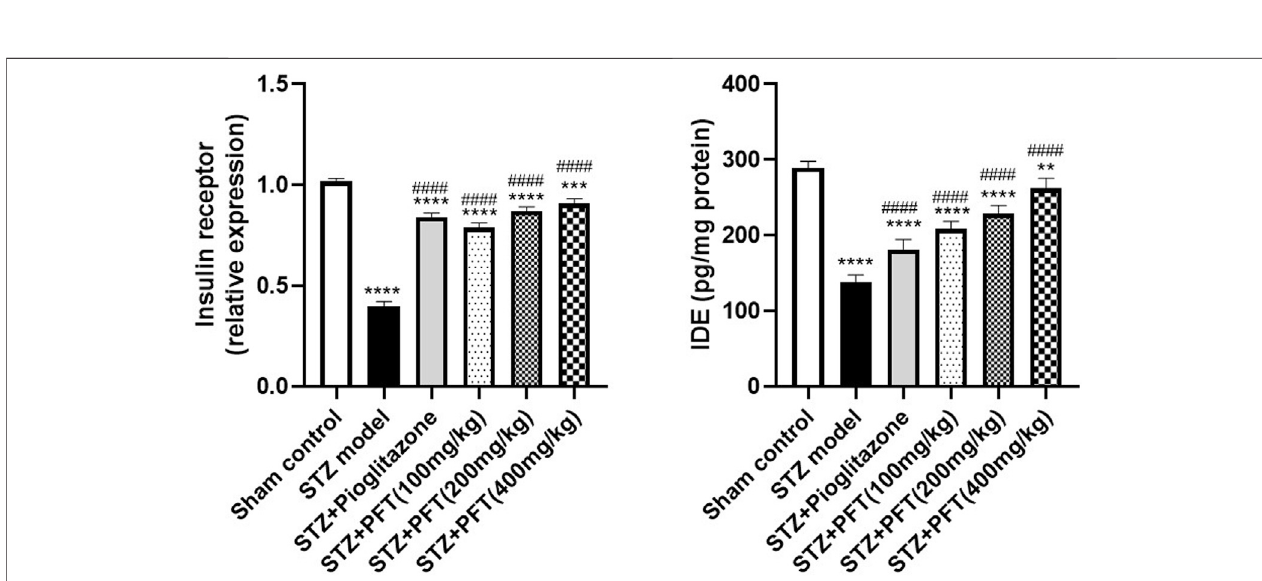
FIGURE 3 | PFT reversed STZ-induced variations in the insulin receptor expression and IDE level in the hippocampus. Each bar with vertical line represents the mean ± SDofthreemicepergroupforinsulinreceptorexpressionandofsixmicepergroupforIDElevel; ** signi fi cantlydifferentfromtheshamcontrolgroupat p < 0.01, *** signi fi cantly different from the sham control group at p < 0.001, **** signi fi cantly different from the sham control group at p < 0.0001, #### signi fi cantly different from the STZ group at p < 0.0001 using One-Way ANOVA followed by Tukey ’ s multiple comparisons test.